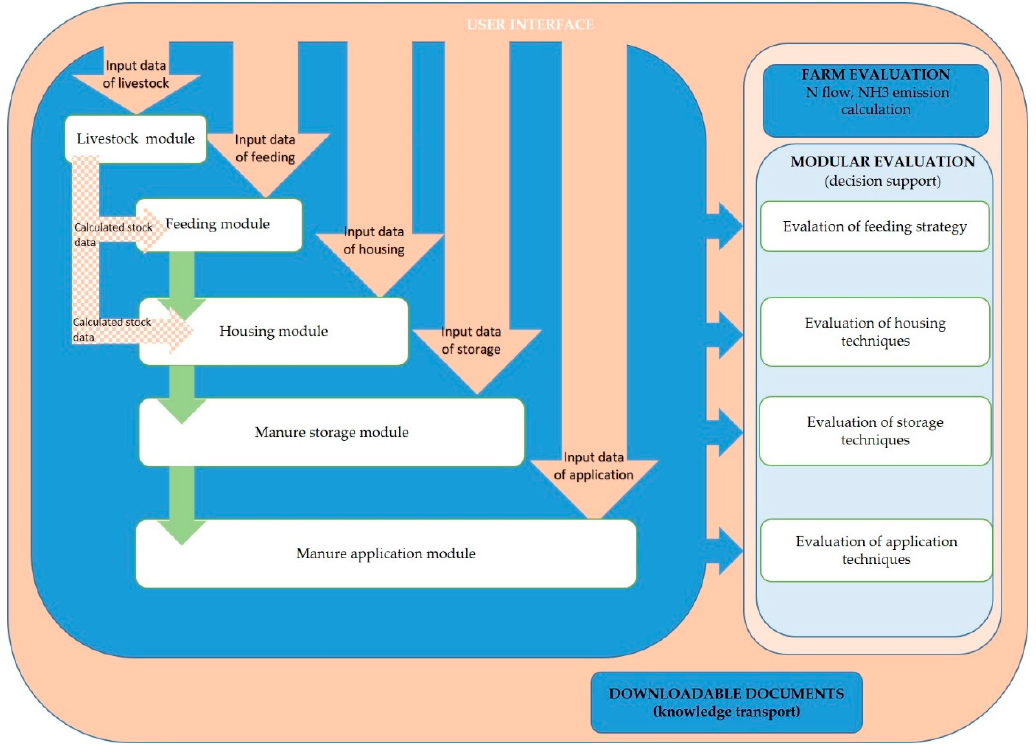
Figure 1. General structure of AGEM-S.